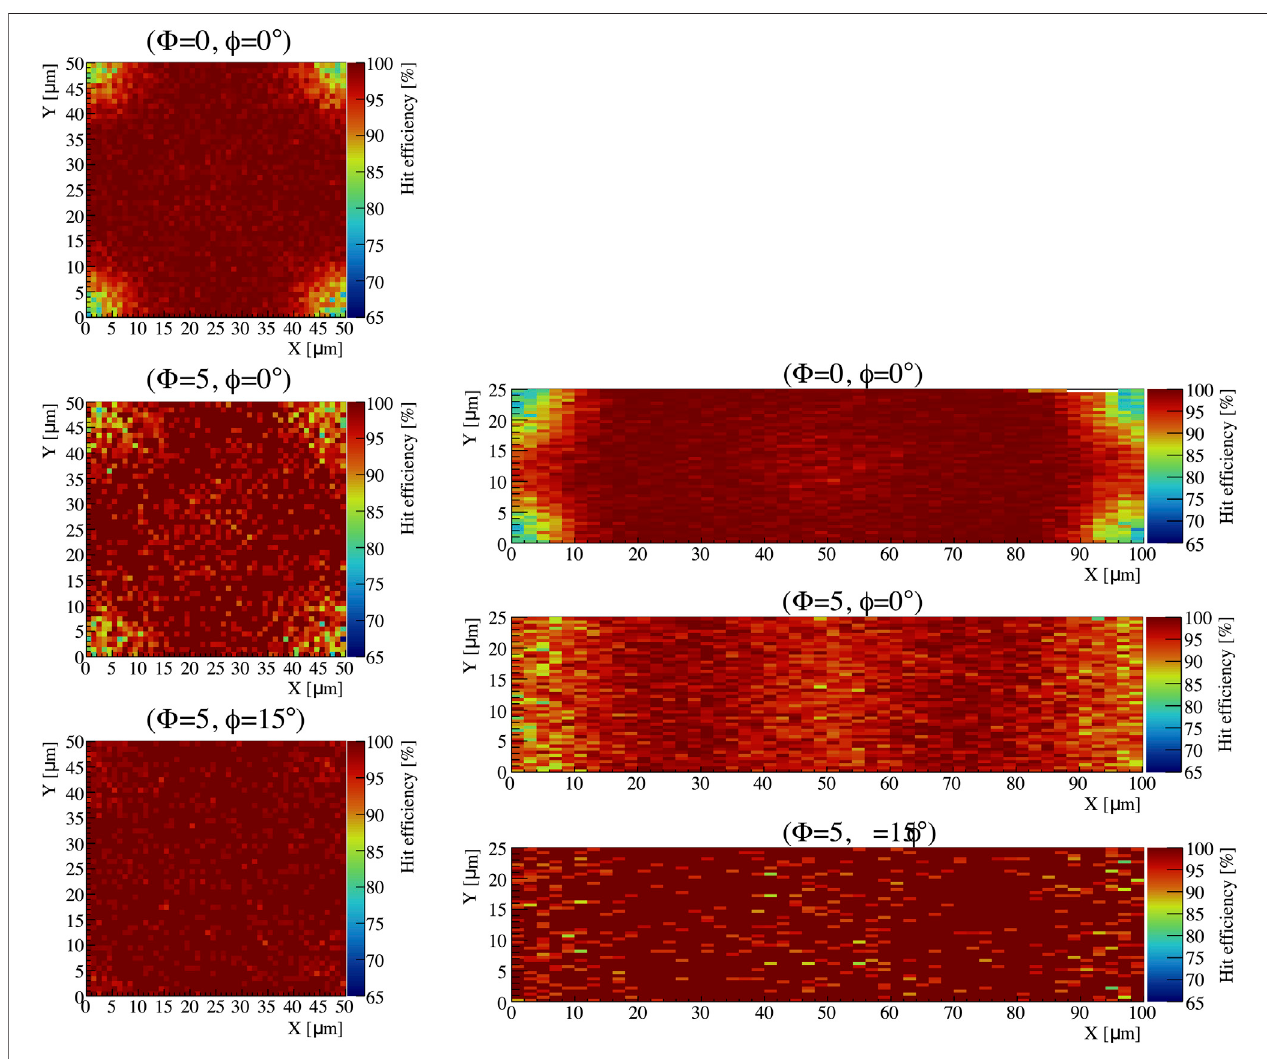
FIGURE 12 | Hit ef fi ciency over the surface of one pixel cell with 50 × 50 − 1E (left) and 25 × 100 − 1E (right) geometries [25]. From top to bottom the maps show modulesmeasuredbeforeirradiationatperpendicularbeamincidence( Φ (cid:2) 0, ϕ (cid:2) 0),afterirradiationto5 × 10 15 n eq /cm 2 atperpendicularbeamincidence( Φ (cid:2) 5, ϕ (cid:2) 0) and at15 ° beam incidence angle ( Φ (cid:2) 5, ϕ (cid:2) 15).Thehitef fi ciencymapsofthepixelcellsareobtaineddisplaying thereconstructed track impactpointexpressed inpixel coordinates and projecting the data for all identical structures onto the same image.